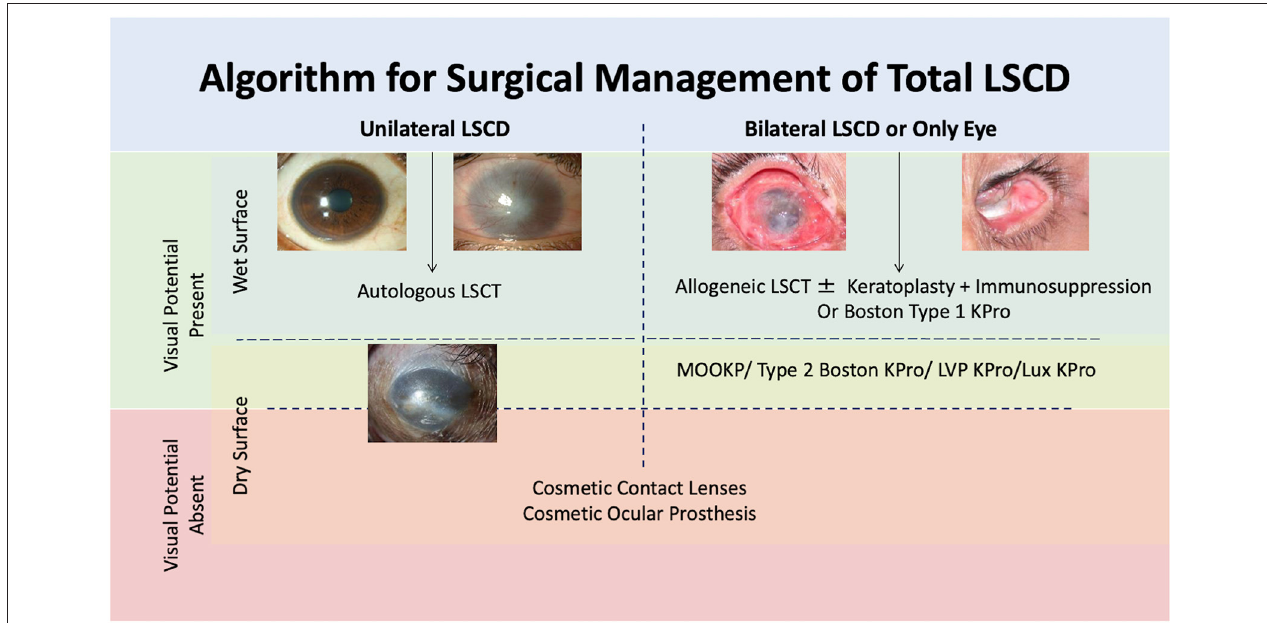
FIGURE 6 | Algorithmic approach of management of limbal stem cell deficiency (LSCD). LSCT: limbal stem cell transplantation, KPro: keratoprosthesis, MOOKP: modified